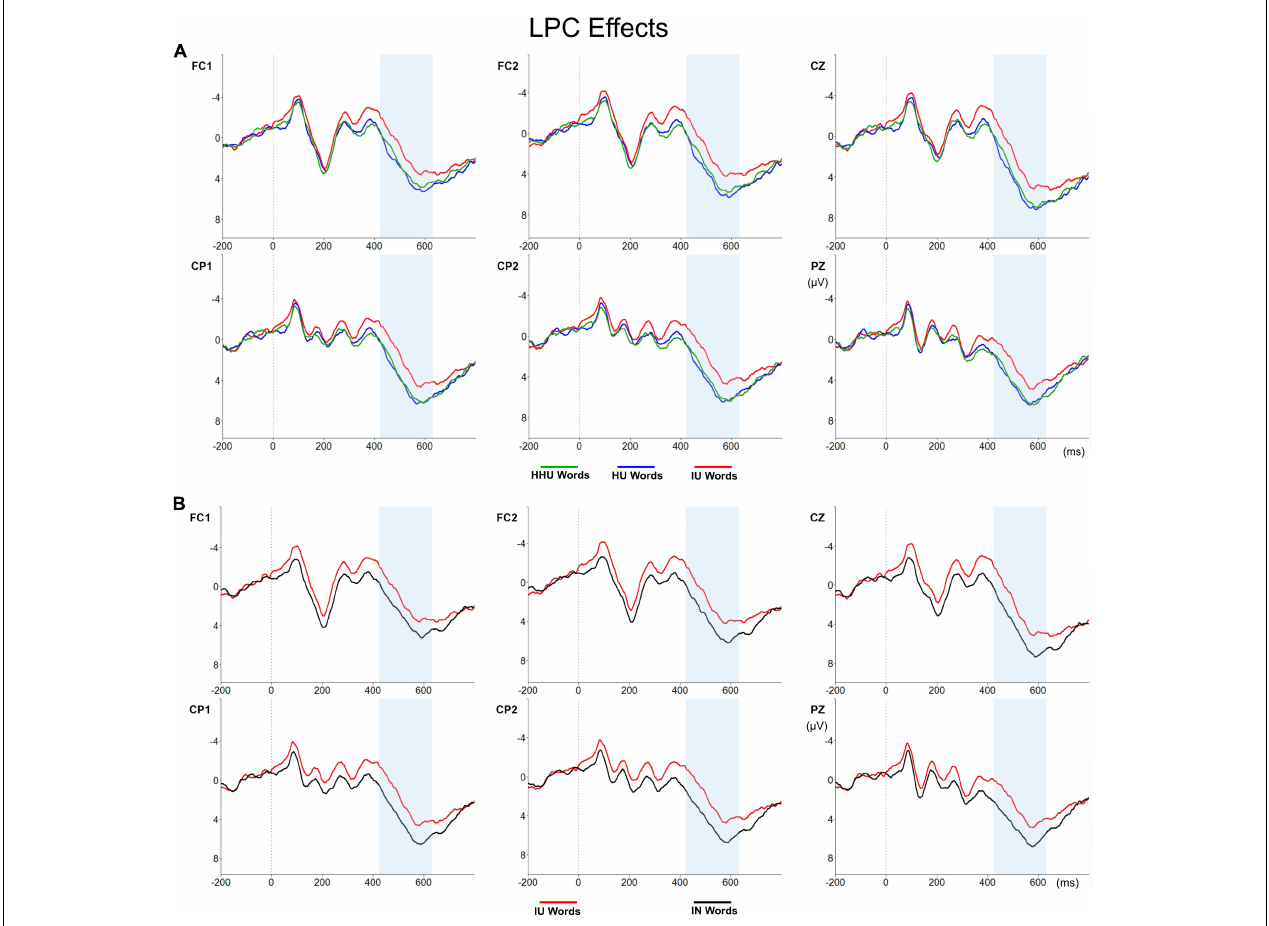
FIGURE 2 | LPC effects. (A) LPC amplitudes for HHU (green line), HU (blue line), and IU words (red line). The time range of the LPC component is indicated by a blue rectangle. (B) LPC amplitudes for the IU (red line) and the IN words (black line). The time range of the LPC component is indicated by a blue